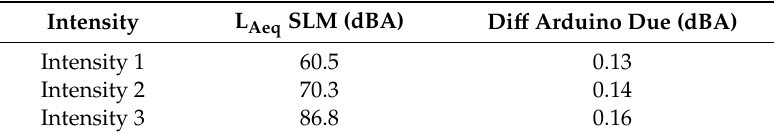
Table 5. The Arduino Due measurements in the lab.